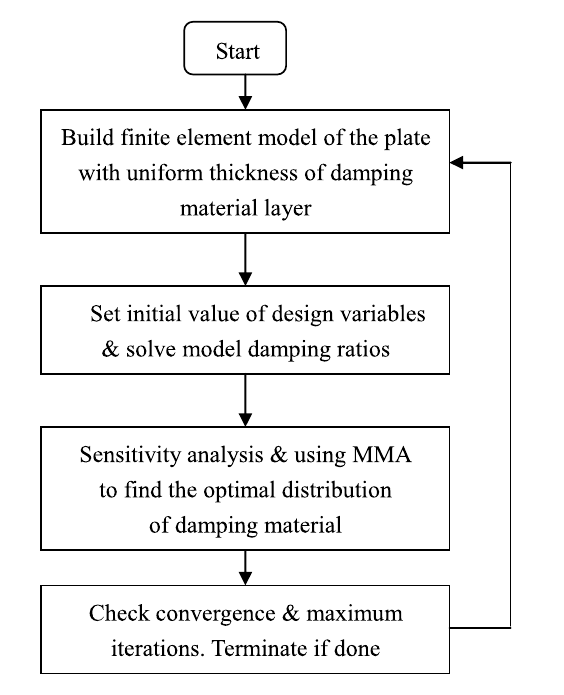
Fig. 3. Block diagram for the optimization procedures.